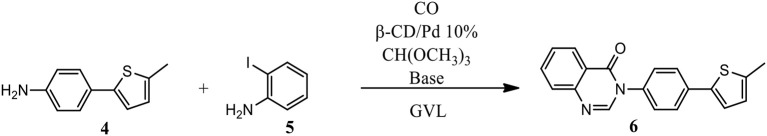
Carbonylative coupling reaction.